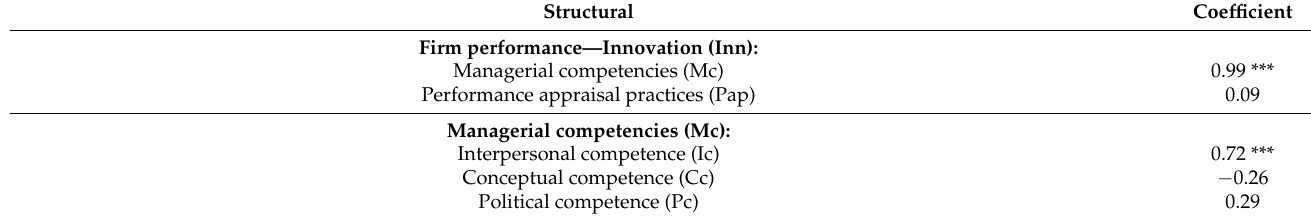
Table 3. Influence of managerial competencies and performance appraisal on firm innovation.